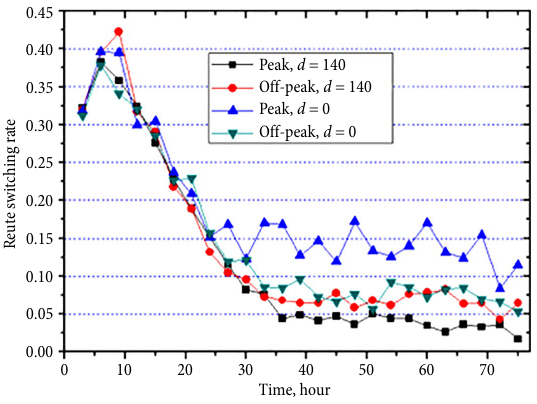
Fig. 11. Route switching rate when the VMS is set at Node 2 and 140 m from the front of Node 2 during peak and off-peak